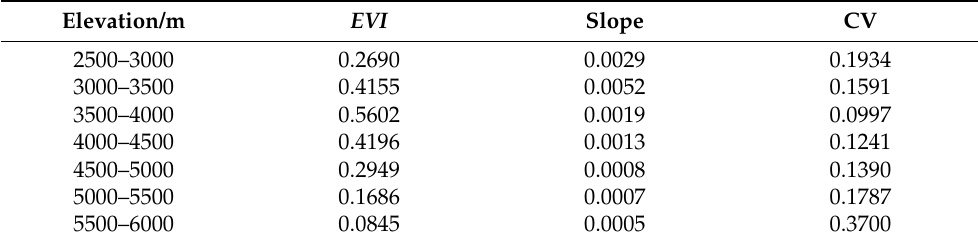
Table 2. Variation in vegetation growth status on the elevation